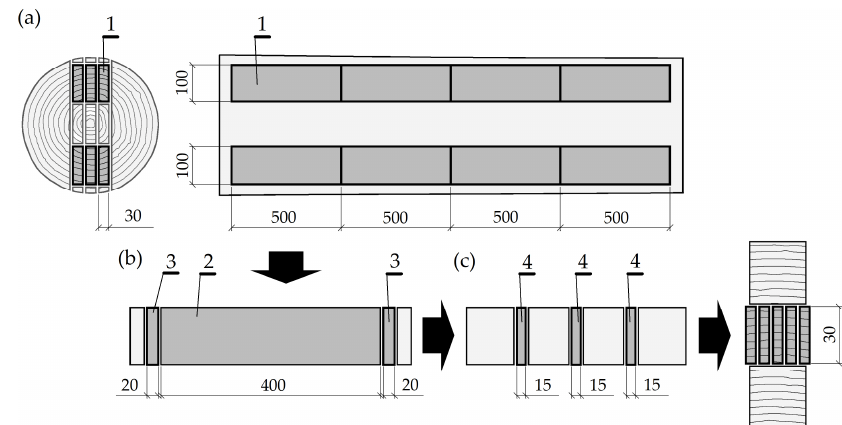
Figure 1. Scheme of sample preparation: ( a ) initial sawing of boards from a log (1—strip with green dimensions), ( b ) cutting pattern of samples before drying (2—main sample, 3—sub-samples to determine initial moisture content), ( c ) cutting pattern of samples after drying (4—additional